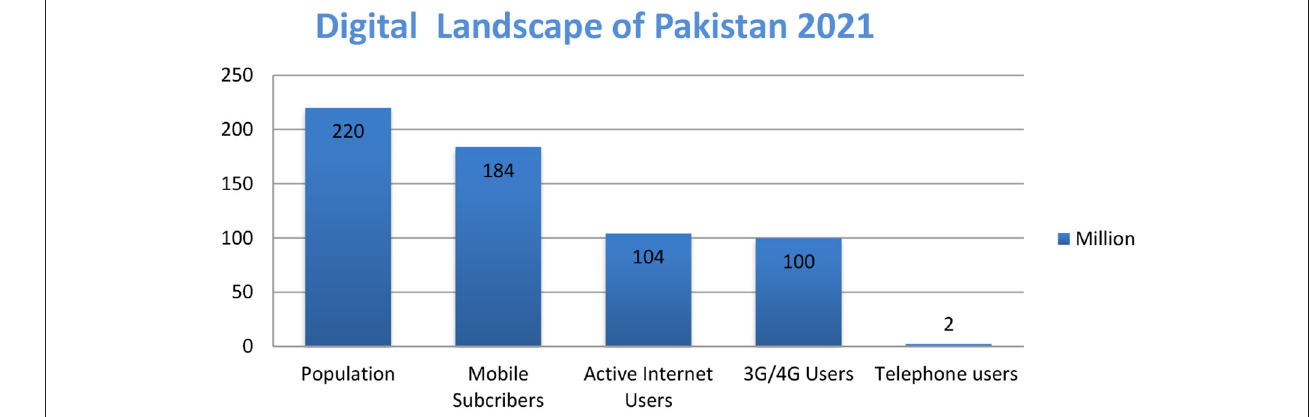
FIGURE 2 | Digital landscape of Pakistan 2021.